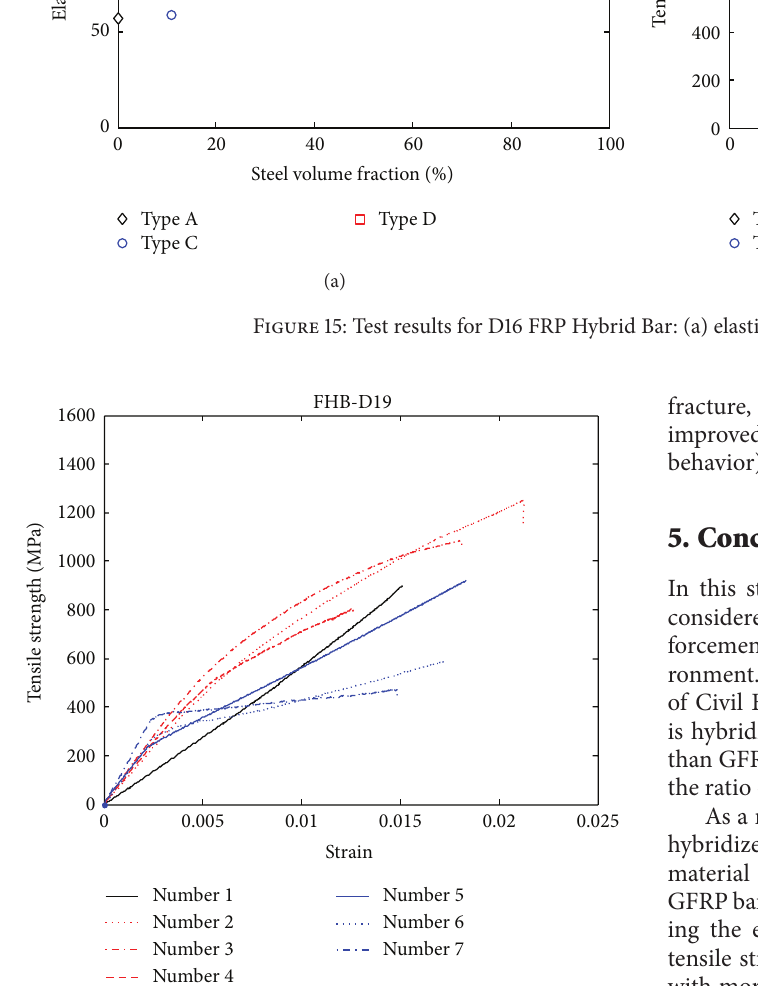
Figure 16: Stress-strain curves of D19 FRP Hybrid